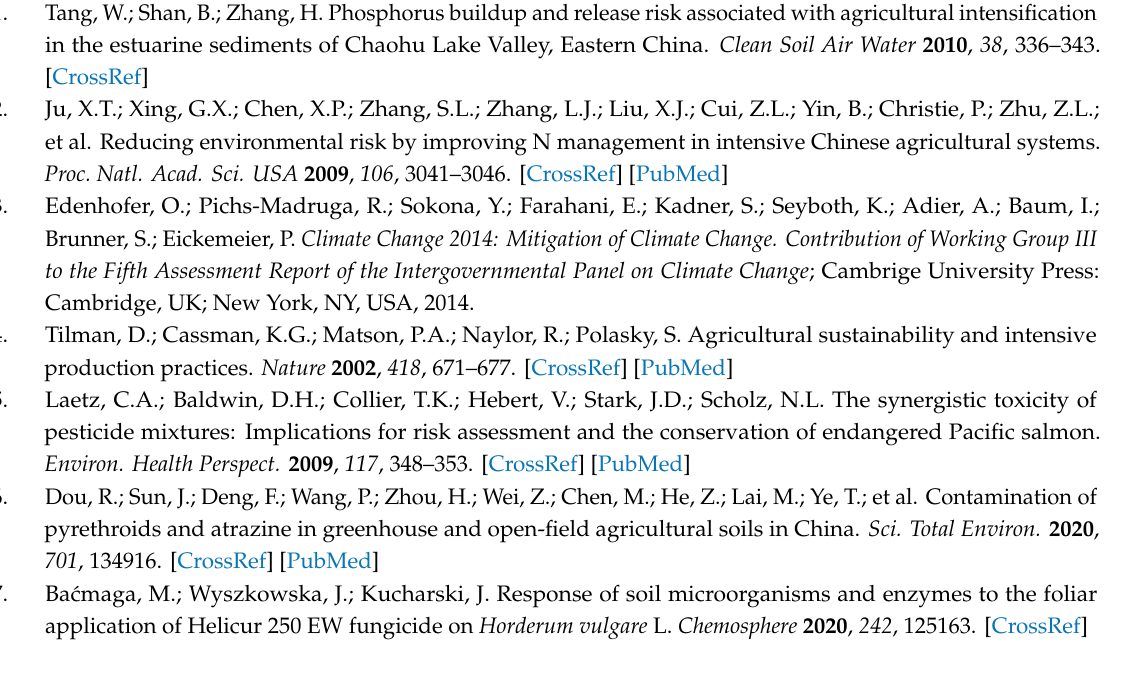
Table S1: The e ff ects of management system, inoculum type, and their interaction on plant growth parameters as revealed by two-way ANOVA. (**: p < 0.01, ns: non-significant); Table S2: The e ff ects of management system, inoculum type, and their interaction on microbial groups and PLFAs ratios as revealed by Two-way ANOVA (*: p < 0.05, **: p < 0.01, ***: p < 0.001, ns: non-significant); Table S3: The e ff ects of management system, inoculum type, and their interaction on microbial groups and PLFAs ratios as revealed by Two-way ANOVA (*: p < 0.05, **: p < 0.01, ***: p < 0.001, ns: